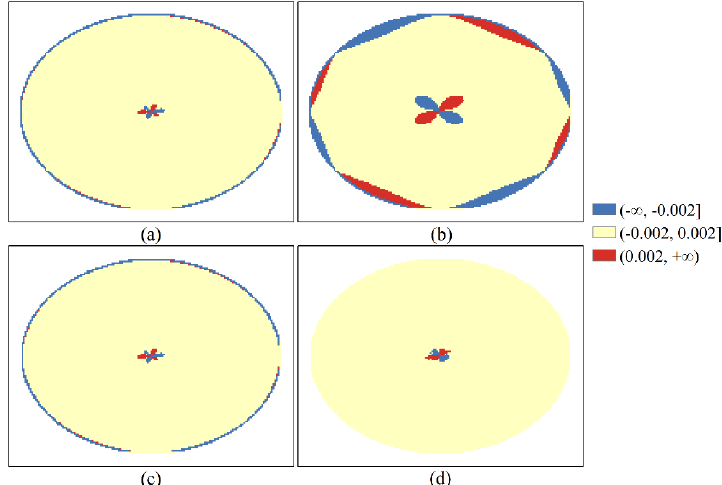
Figure 9. Spatial distribution of the residuals of the simulated C values relative to the theoretical C values on E1, E2, E3, and E4 for the: ( a ) Evans, ( b ) Zevenbergen, ( c ) Shary, and ( d ) FPN-based methods.